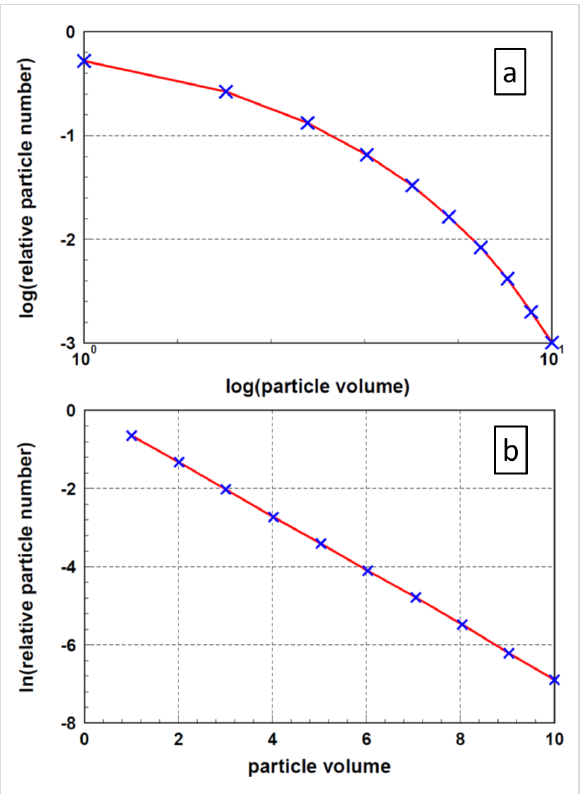
Figure 5: Distribution function of particle sizes according to Kätelhön and co-workers [18]. Figure 5a displays the results as published by the authors in a double logarithmic plot (base 10), Figure 5b shows the same results, in accordance with Figure 2, in a linear–logarithmic (base e ) plot.